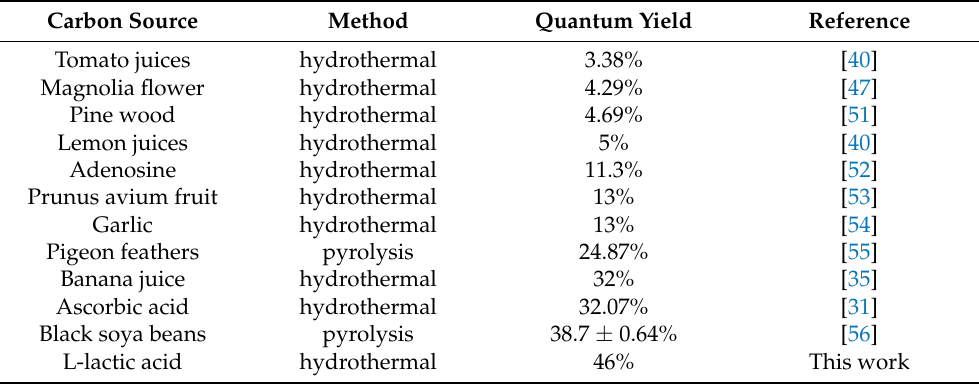
Table 1. The quantum yield of CQDs synthesized from biomass as a carbon